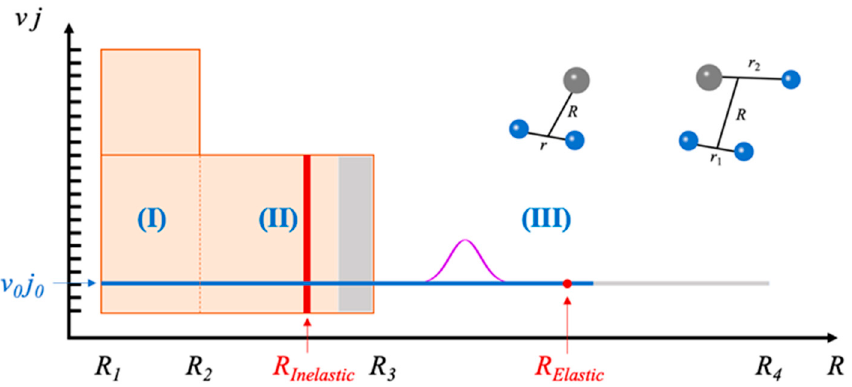
Figure 1. Illustrative drawing of the grids used for the IALR-WP method. Red curves represent the projection plane where time-independent wave functions are collected, gray represents the region of damping functions.